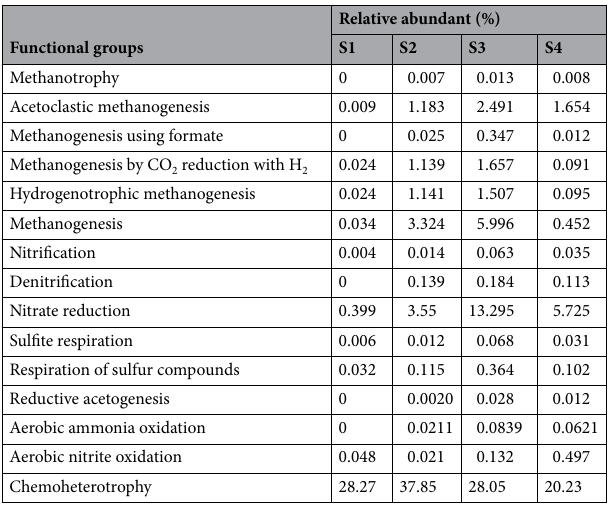
Table 2. Functional profile among phylogenetic groups of microbial communities in anodic